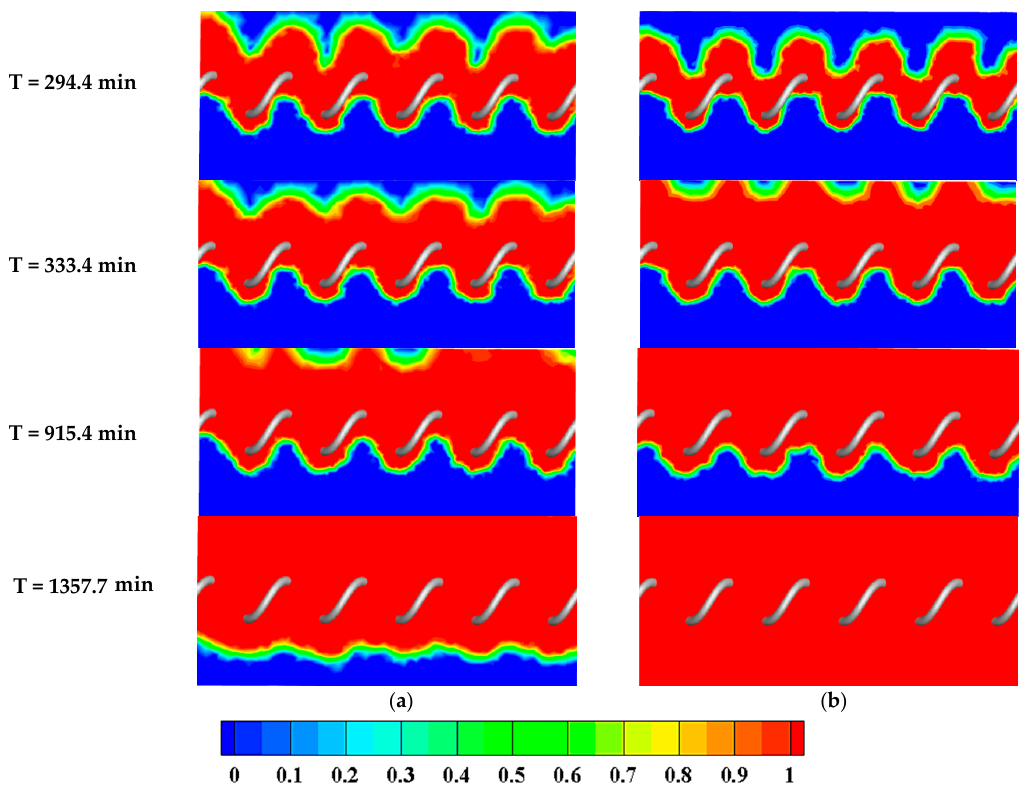
Figure 9. Contours of the liquid fraction at four different times and two HTF inlet temperature of ethylene glycol: ( a ) T inlet = 7.5 °C and ( b ) T inlet = 10 °C.